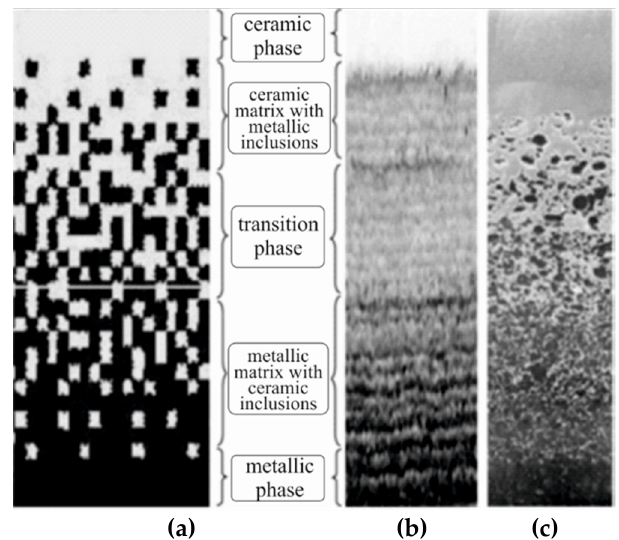
Figure 1. Schematic of continuously graded microstructure with metal-ceramic constituents: ( a ) smoothly graded microstructure; ( b ) enlarged view; ( c ) ceramic-metal functionally graded materials (FGM).